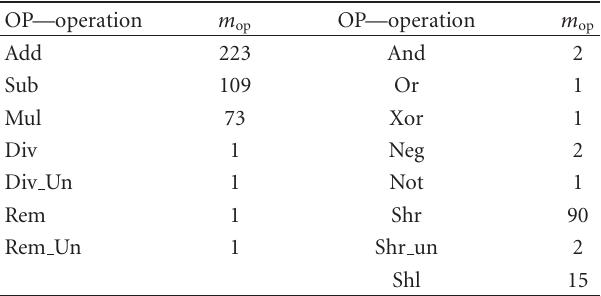
Table 1: Application requirement for arithmetic and logic opera- tions for Mp3 application.